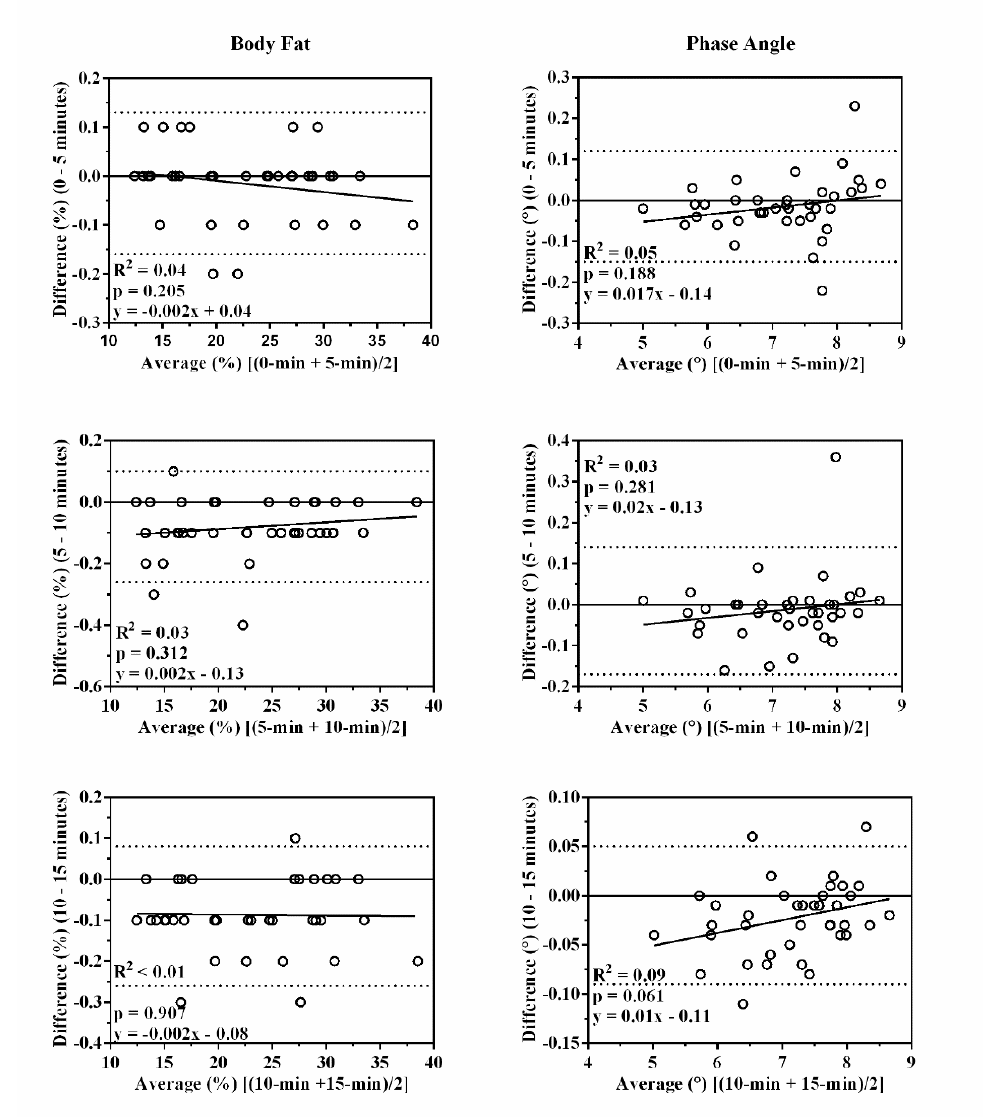
Fig. 6: Bland and Altman plots of individual differences for the effect of time since transitioning from a vertical to a supine position on body fat (left side) and phase angle (right side) (N = 38). The solid line represents a mean difference (bias) of zero. The dashed lines denote the upper and lower limits-of-agreement (bias ± [1.96×SD of the bias]). R 2 represents the amount of variance explained by the average value. *p<0.05 significant systematic